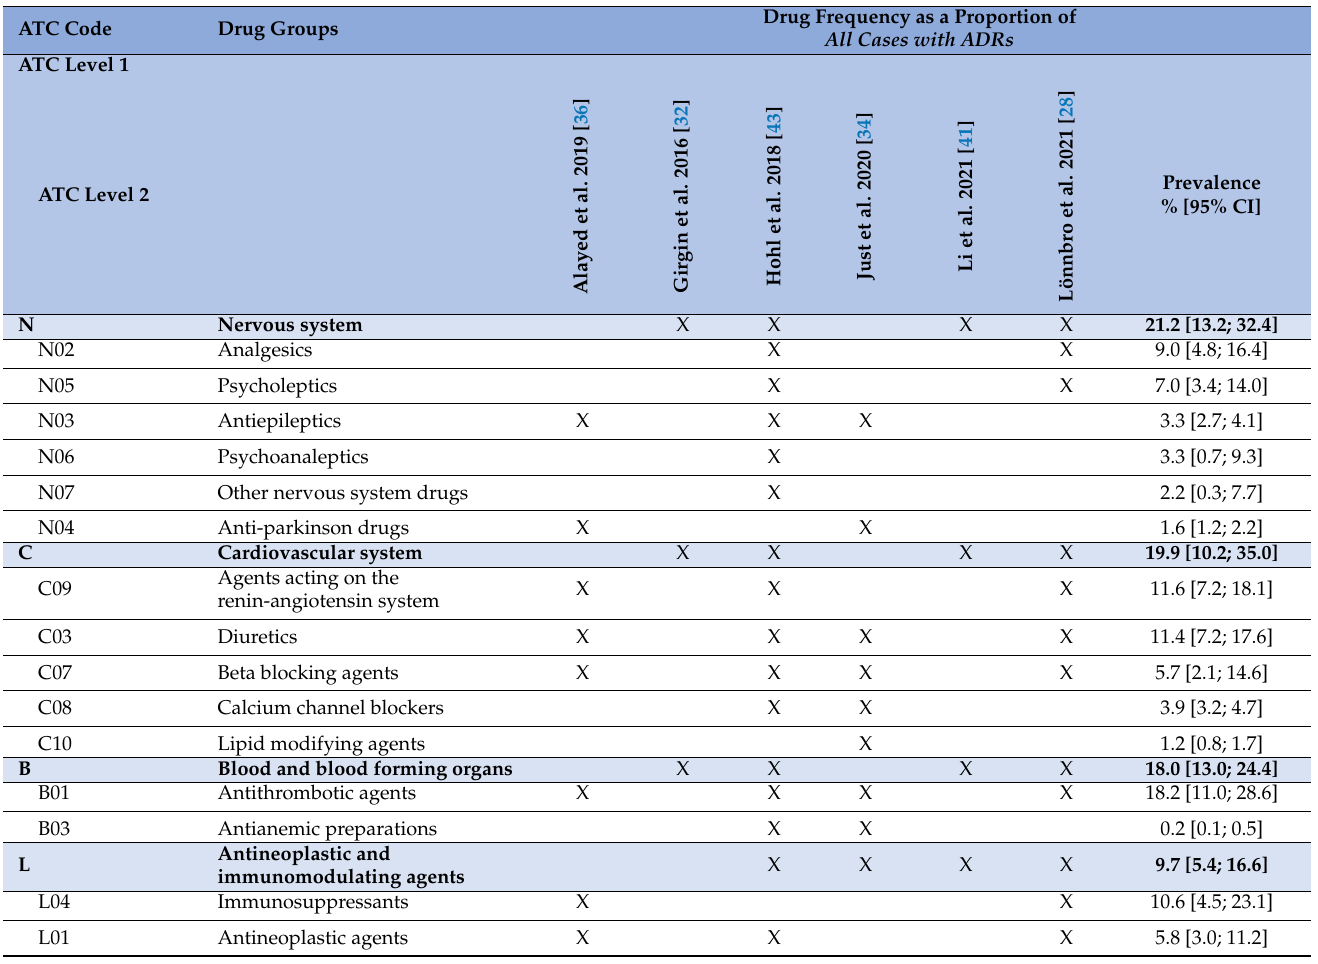
Table 3. Drug groups implicated in ADR-related admissions in hierarchical descending order of estimated point prevalence. The X marks studies contributing to the corresponding meta-analysis. Drug Frequency as a Proportion of ATC Code Drug Groups All Cases with